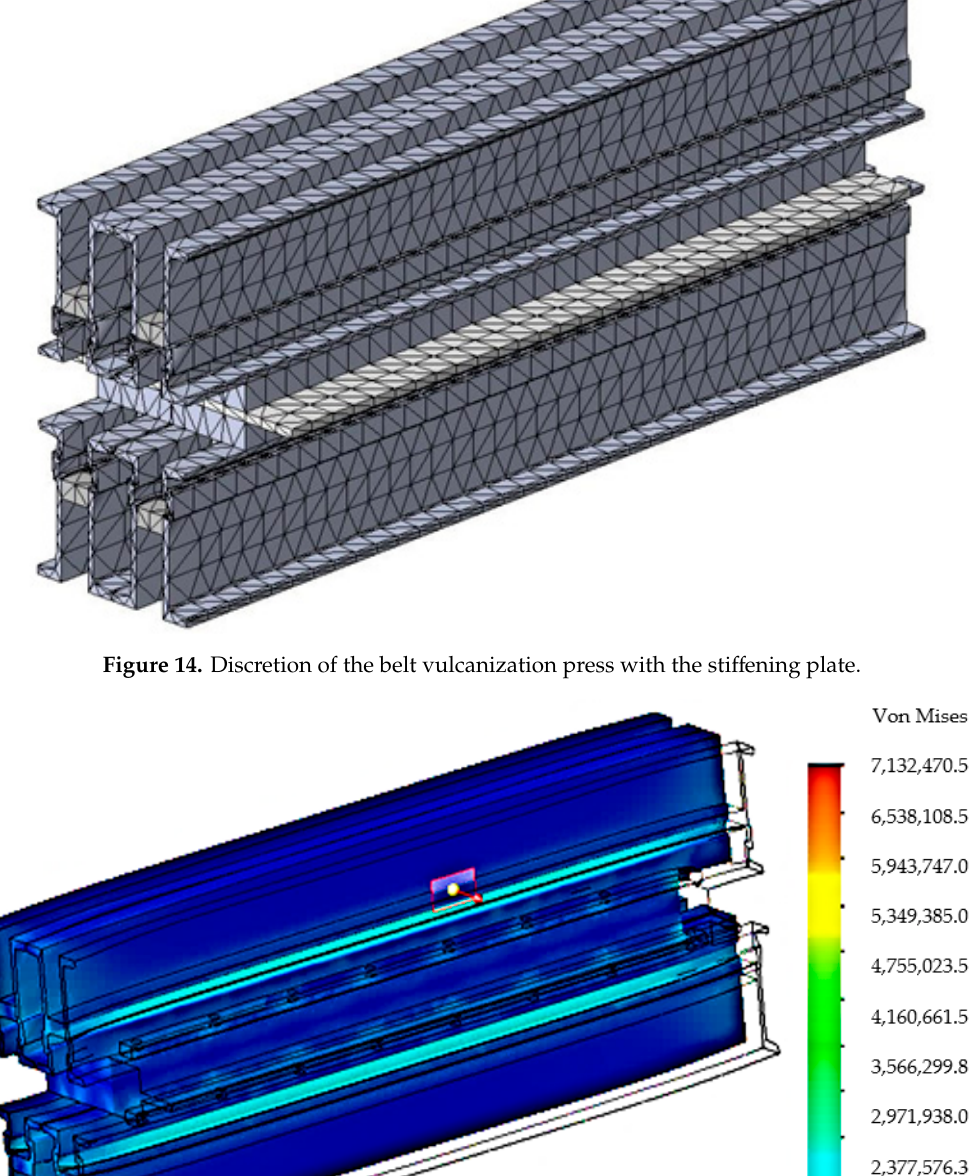
Figure 13. Belt vulcanization press with additional stiffening.